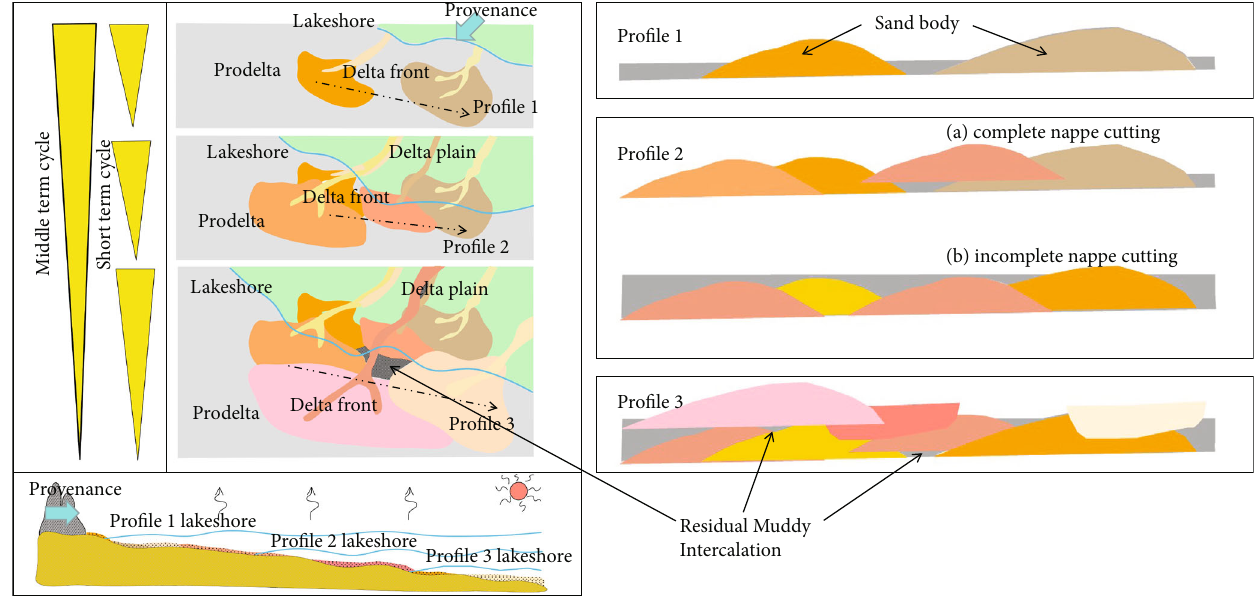
Figure 8: Formation mechanism of muddy intercalation under the background of lake regression.